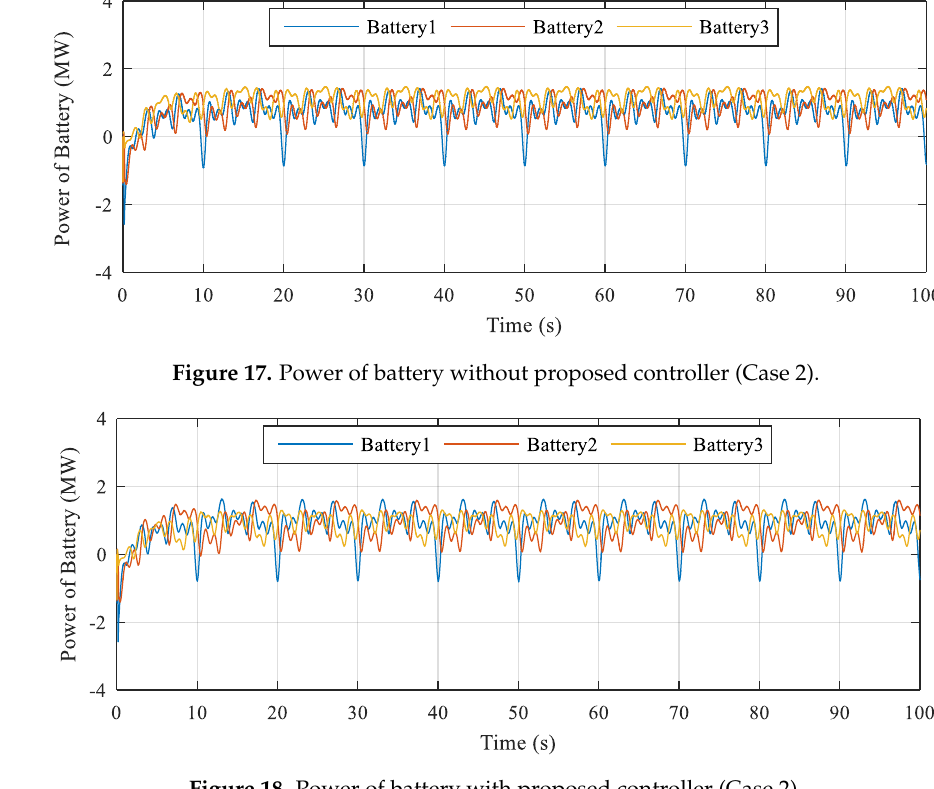
Figure 18. Power of battery with proposed controller (Case 2).